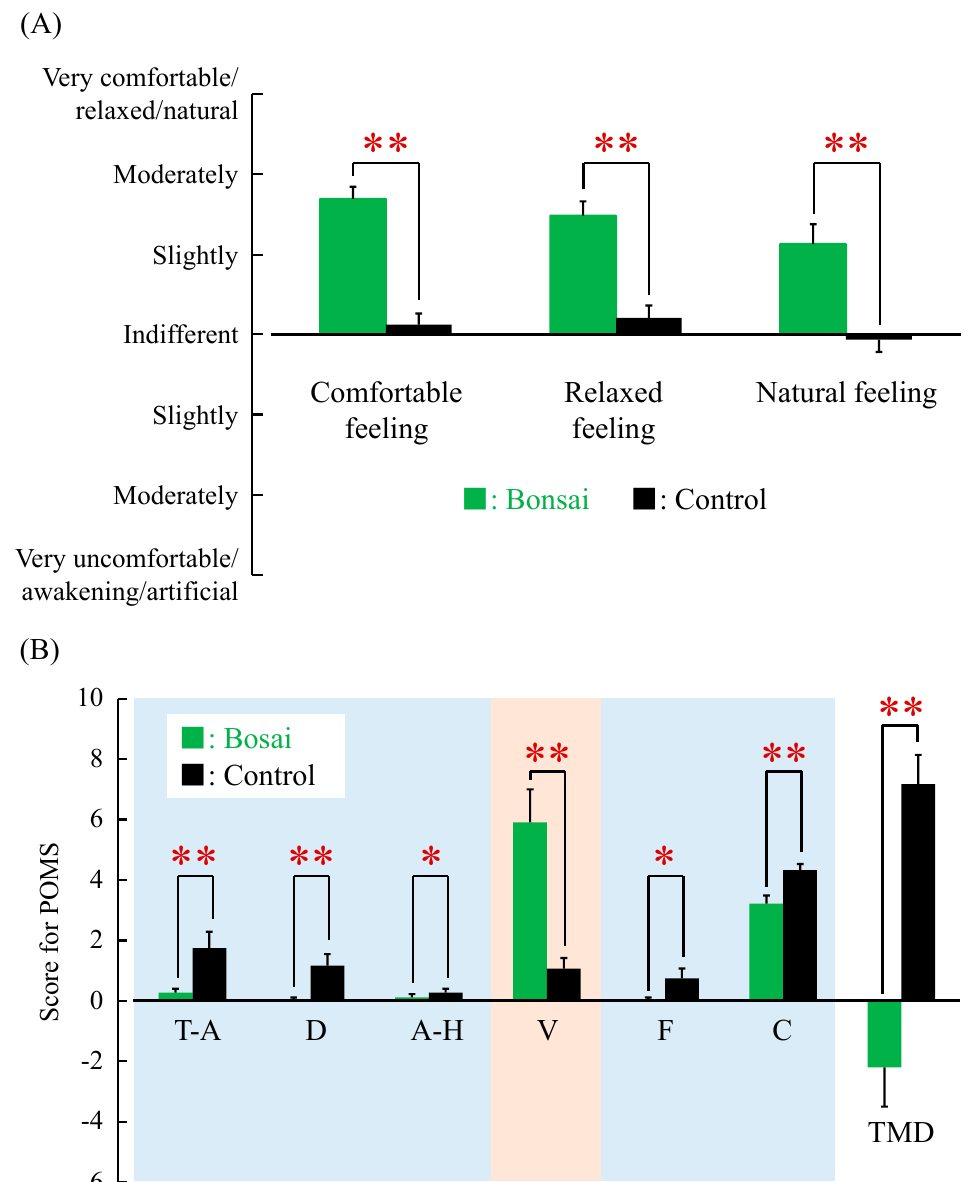
Figure 4. Questionnaire results. ( A ) Subjective feelings measured using the modified semantic differential method after viewing the bonsai trees vs. control. N = 24, mean ± standard error. ** p < 0.01, Wilcoxon signed ‐ rank test; ( B ) Scores on the Profile of Mood States after viewing the bonsai trees vs. control. T ‐ A, tension ‐ anxiety; D, depression; A ‐ H, anger ‐ hostility; V, vigor; F, fatigue; C, confusion; and TMD, total mood disturbance. N = 19, mean ± standard error. * p < 0.05 and ** p < 0.01, Wilcoxon signed ‐ rank test.